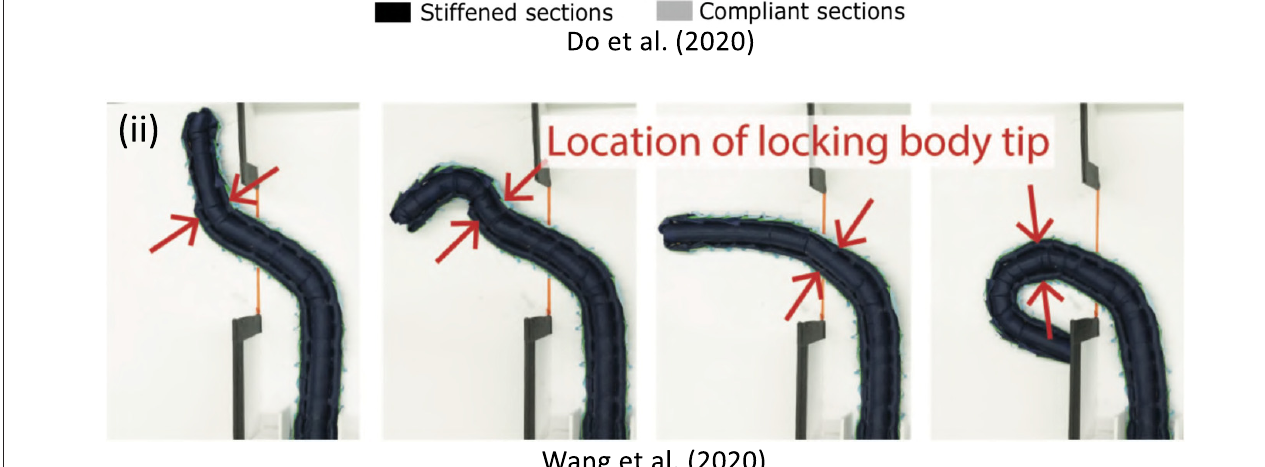
FIGURE 4 | Methods for modifying steering and shape of everting vine robots apart from actuation. (A) Steering can be modified by obstacle interaction, where the robot passively conforms to its environment as it grows. (B) Steering can also be modified by changing the body stiffness. (B,i) Increasing the stiffness of sections through layer jamming allows control of the wrinkling point under tendon actuation. (B,ii) Side tubes can be used to shape-lock previous actuation, allowing steering of the tip only and formation of compound curves. Modified from Greer et al. (2020), Do et al. (2020) © IEEE 2020, and Wang et al. (2020) © IEEE 2020.